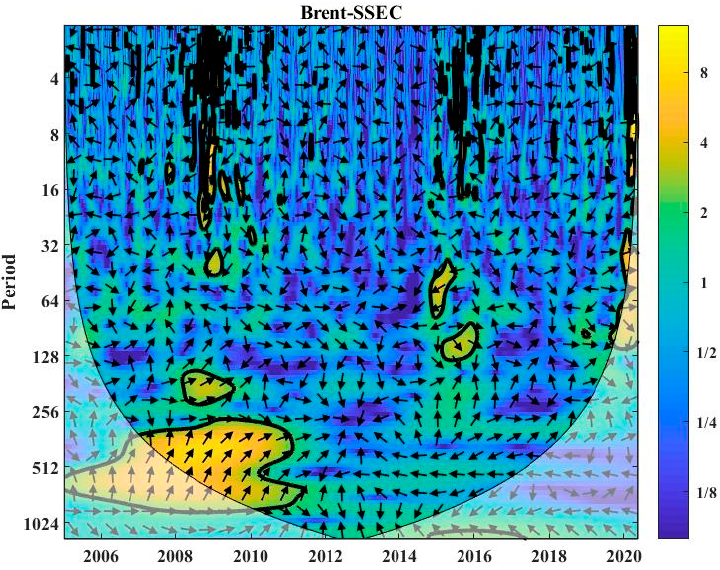
Figure 6. Cross wavelet power frequency spectra of Brent spot price and the Shanghai Composite Index.